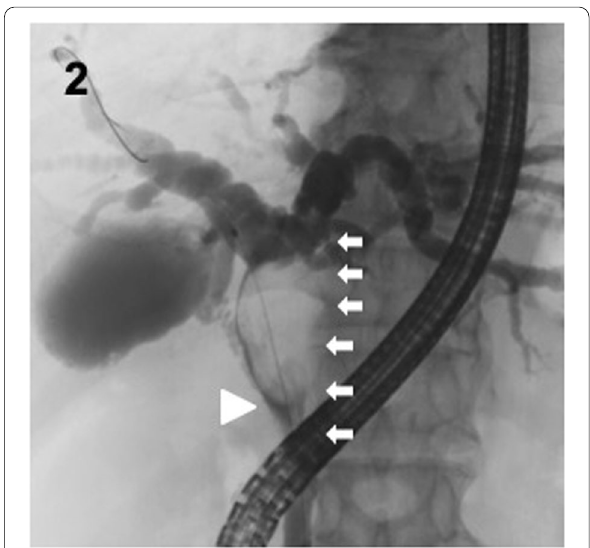
Fig. 2 Endoscopic retrograde cholangiography revealed a protruding tumor in the hilar bile duct with intrahepatic bile duct dilatation. Repeated biopsies showed that the tumor extended from the hepatic duct confluence to the intrapancreatic bile duct around the superior edge of the pancreas. A white arrowhead shows the root of the cystic